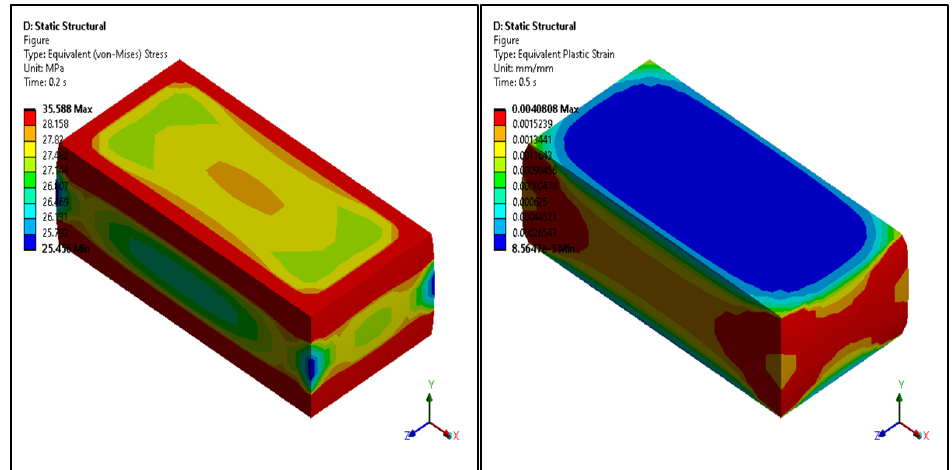
Figure 29. Stress ( left ) and strain ( right ) distribution of sustainable red mud bricks using ANSYS–HA.